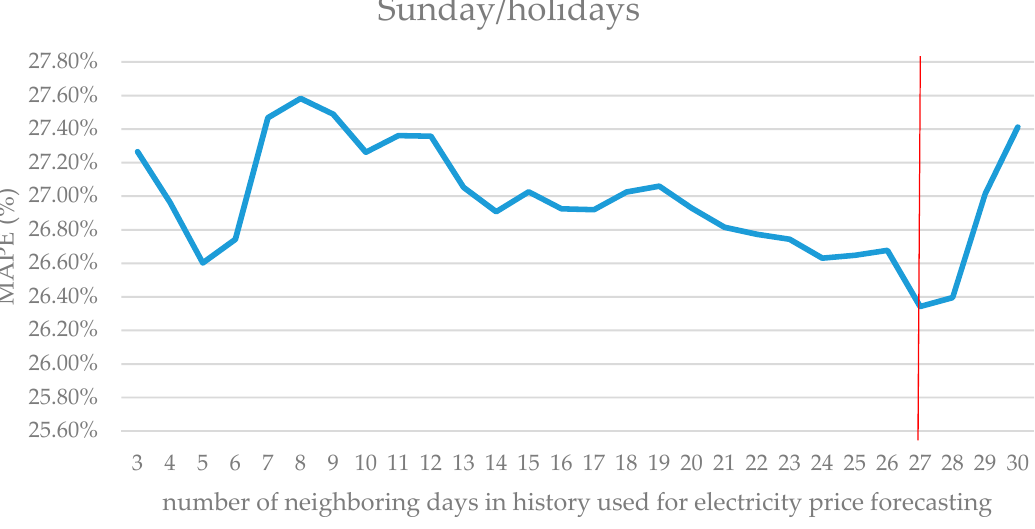
Figure 12. Correlation between price forecasting error and the size of a similar day data set for Sunday and holidays.